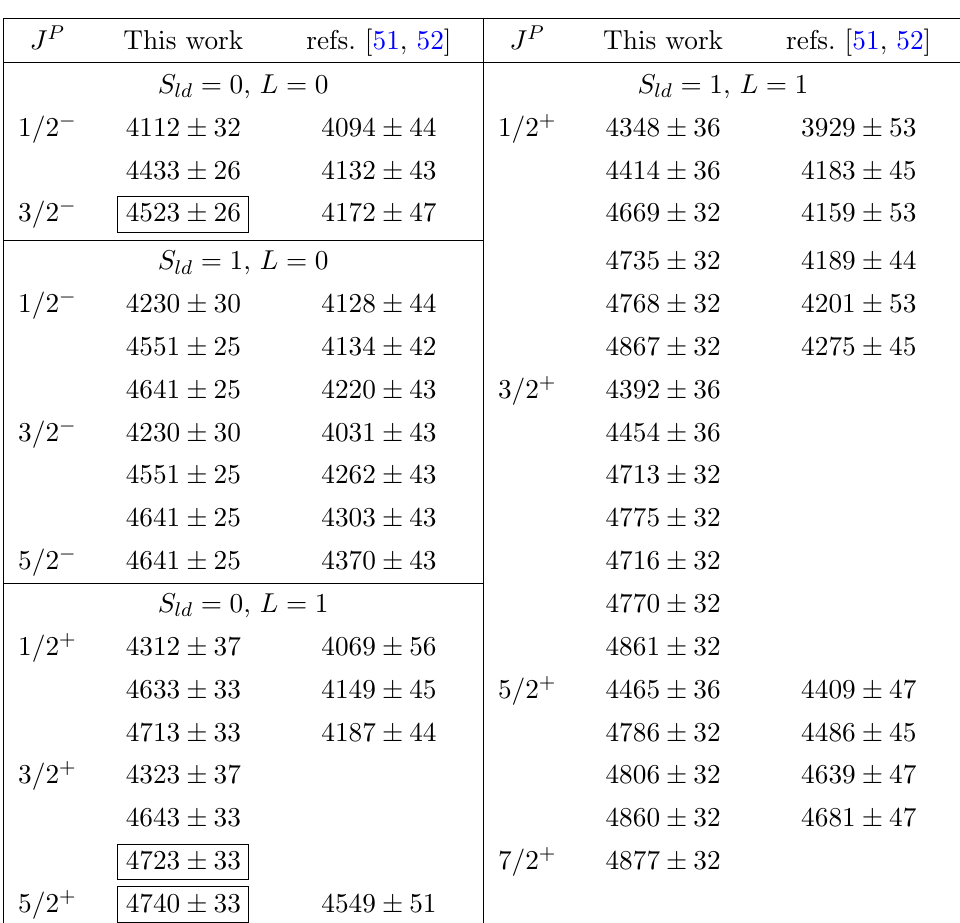
Table 11 . Masses of the hidden-charm strange pentaquarks (in MeV) with a strange-light diquark, i.e. having the structure ((cid:22) c (cid:22)3 [ cq ] (cid:22)3 [ sq 0 ] (cid:22)3 ), where q ( 0 ) is u - or d -quark, and their comparison with the results presented in [51, 52]. For the P -wave pentaquarks, the values of the orbital, spin-orbit and tensor couplings are taken from table